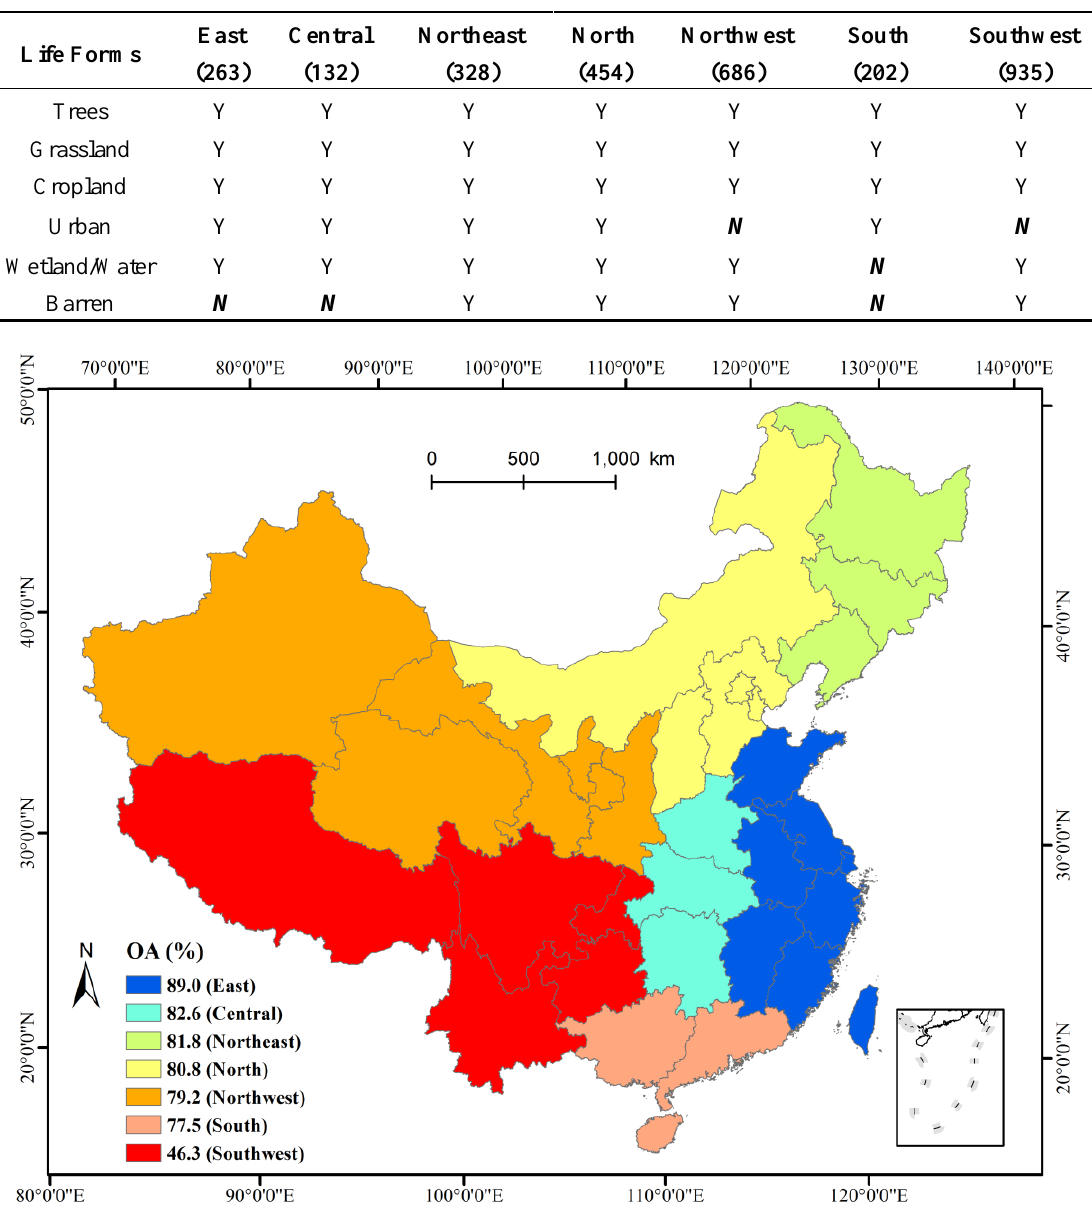
Table 5. Land cover types of sample distributed in each region (“Y” means “type-included”, “N” means “not type-included”). The number in brackets refers to the sum of samples in each region.